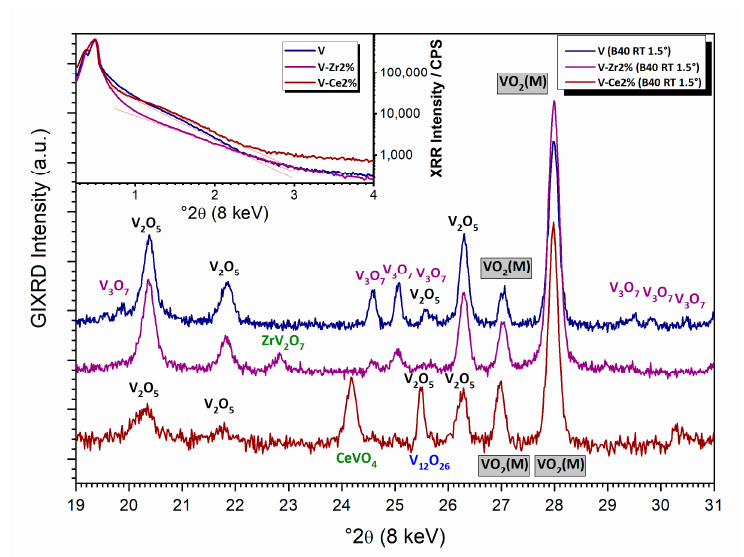
Figure 2. In-operando GIXRD results at 1.5° θ of all samples at room temperature. Inset: XRR scans for all samples.